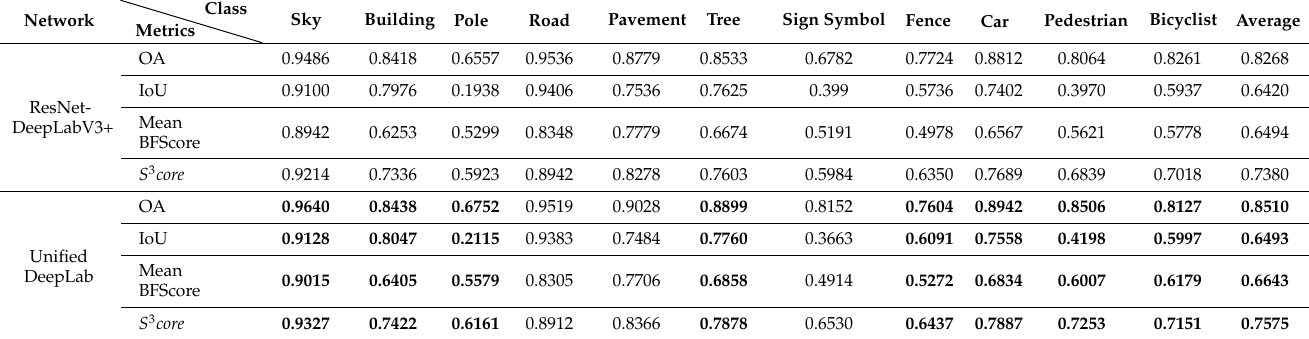
Table 8. Class-wise Comparative Analysis with the State-of-the-Art